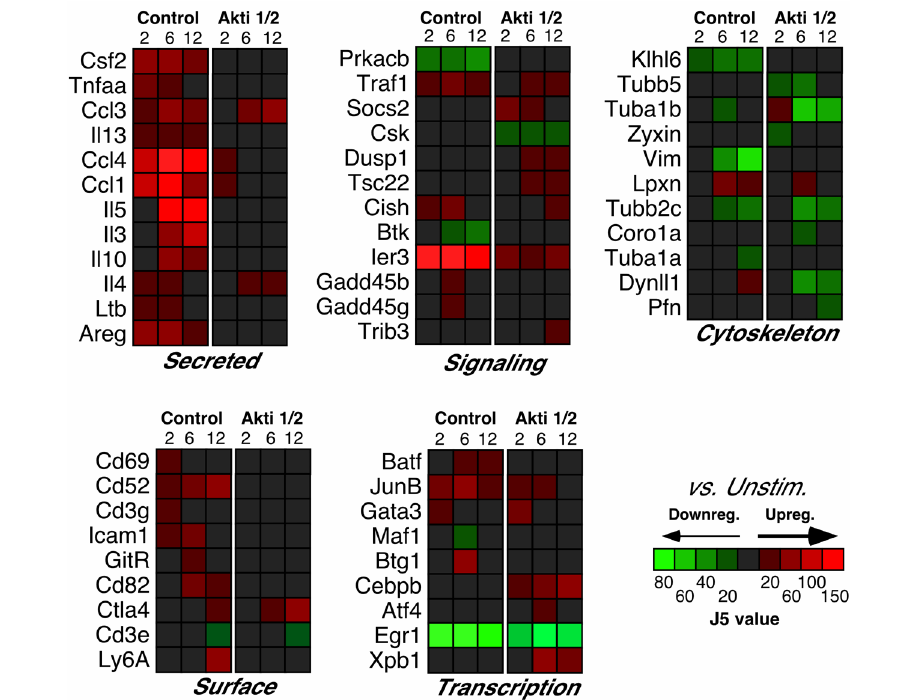
Figure 2. Selected Akt-dependent genes differentially expressed between control (0 h) and 2 h, 6 h and 12 h CD3/CD28 stimulation groups. Relative levels of expression are represented by the J5